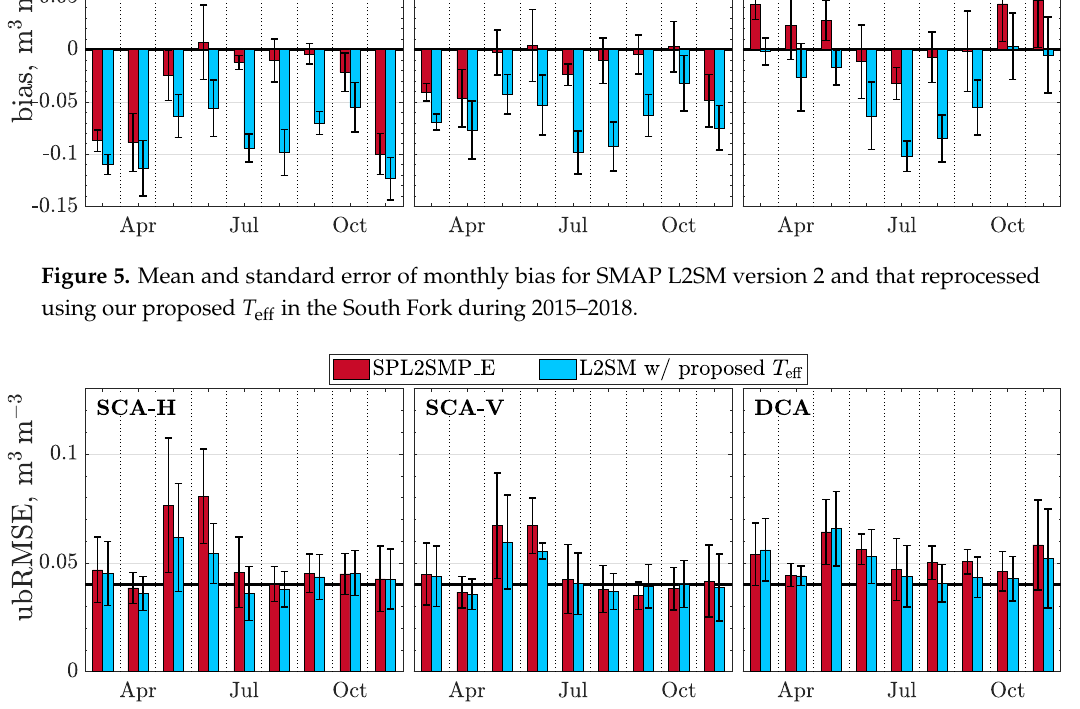
Figure 6. Mean and standard error of monthly ubRMSE for SMAP L2SM version 2 and that reprocessed using our proposed T eff in the South Fork during